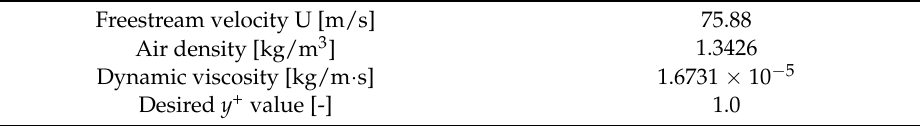
Table 4. Input parameters for initial height